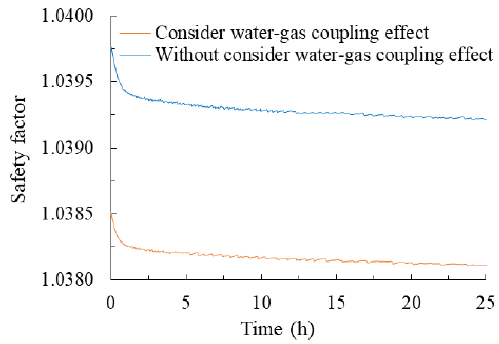
Figure 15. Evolution of safety factor over time.